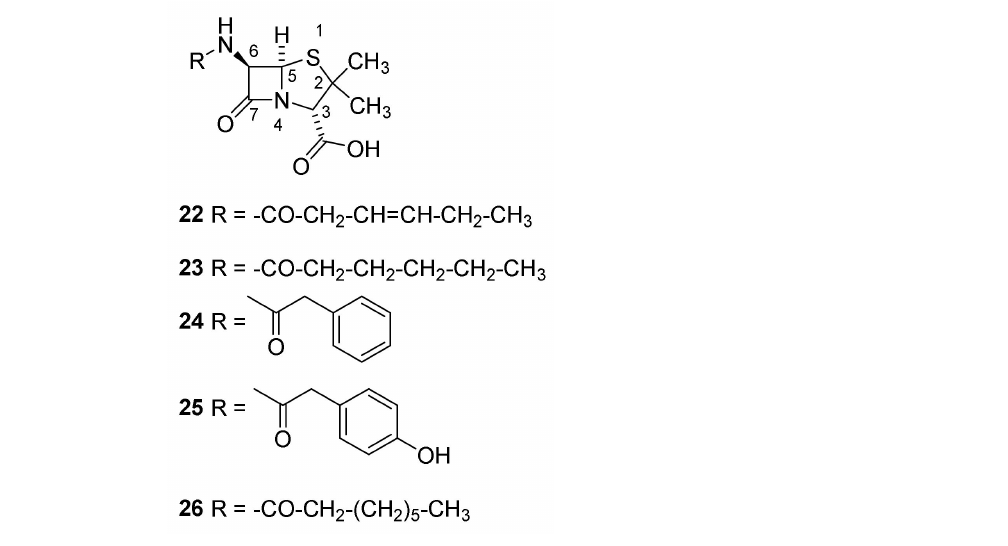
Figure 5. Structures of penicillins with British and American names. Penicillin-I/ F -penicillin ( 22 ), dihydropenicillin-I ( 23 ), penicillin-II/ G -penicillin ( 24 ), penicillin-III/ X -penicillin ( 25 ) and K-penicillin ( 26 ). The side chain is dependent on the Pencillium species and broth from which the penicillin is